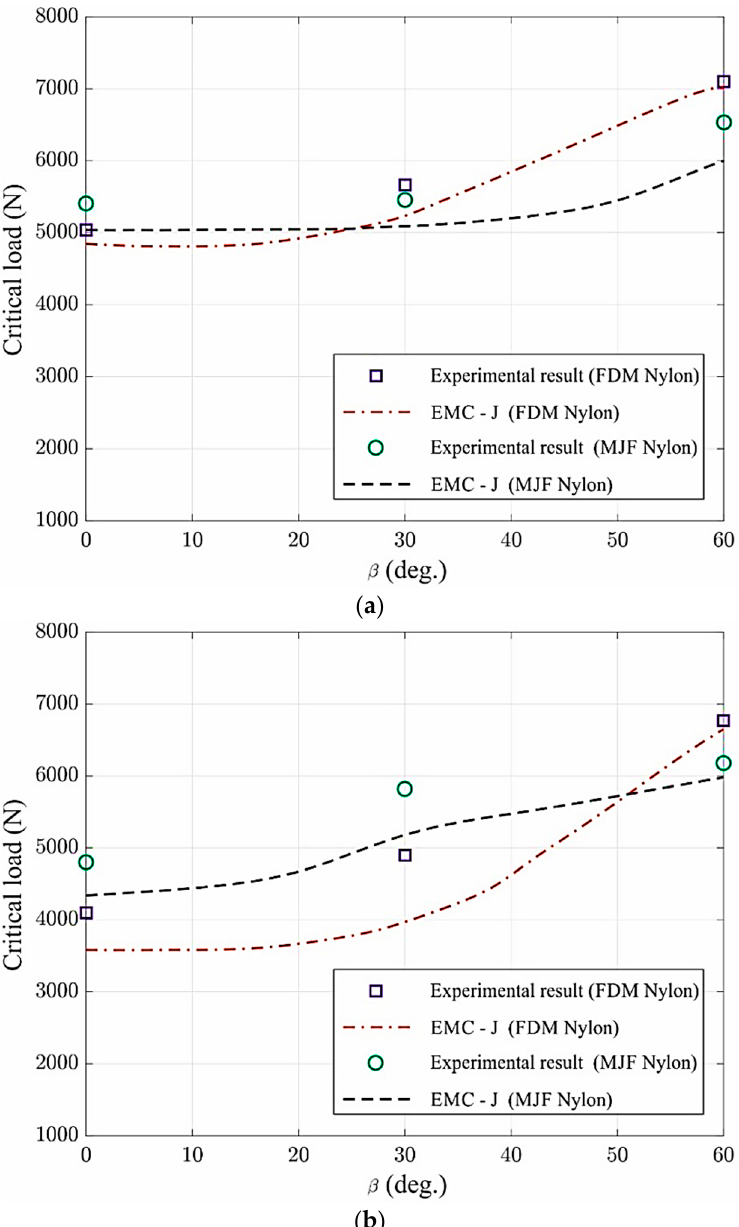
Figure 10. 3D-printed nylon specimens U-notch comparisons via EMC-J criterion; ( a ) ρ = 1 mm, ( b ) ρ = 2